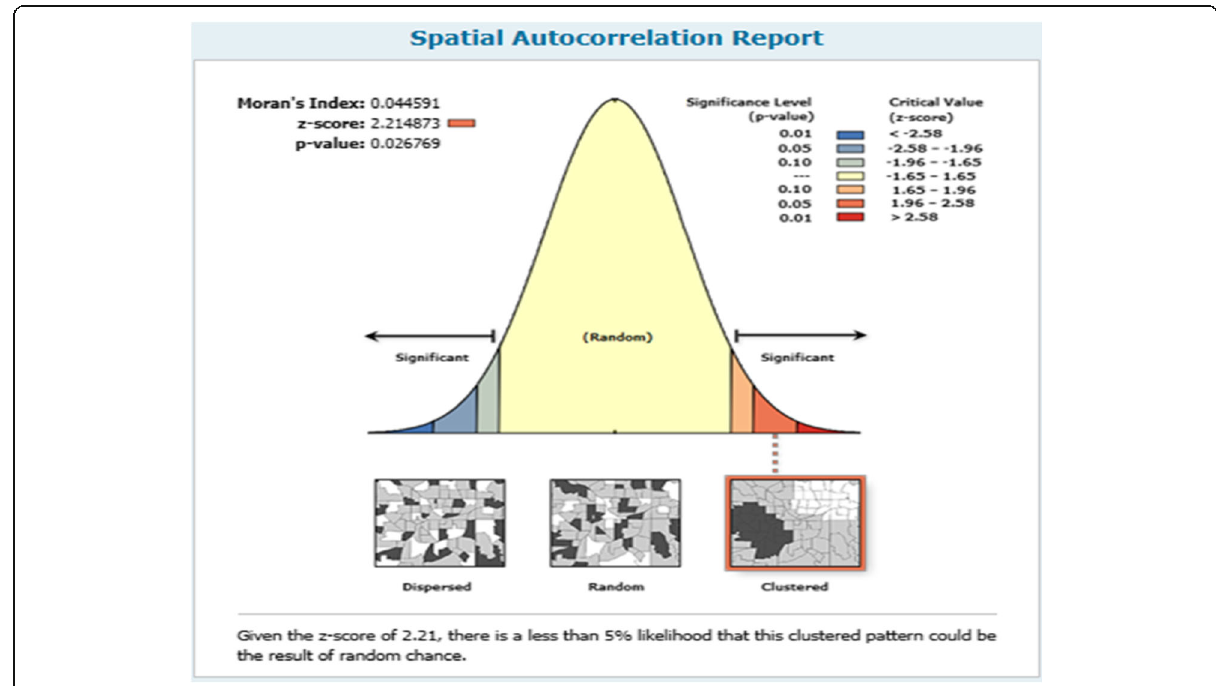
Fig. 2 Spatial autocorrelation of childhood diarrheal disease among under-five children in Ethiopia, EDHS